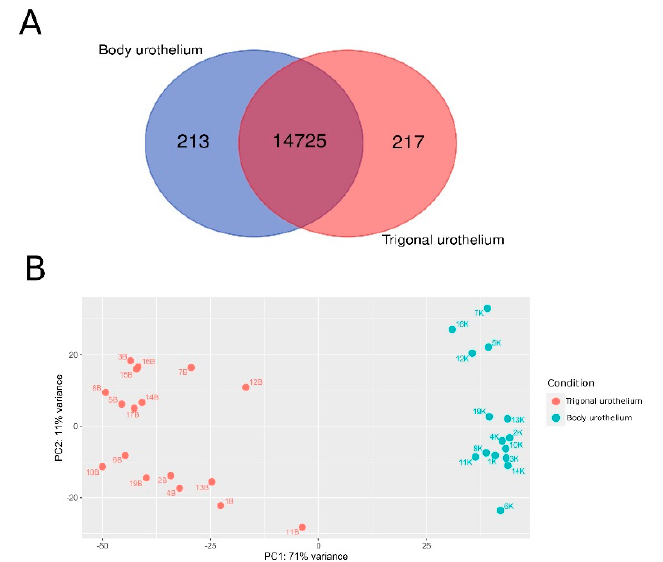
Figure 2. ( A ). Numbers of common and unique genes with noticeable levels of expression (greater than ten reads) in at least three urothelial samples. ( B ). Principal component analysis (PCA) based on transcriptomic profiling, showing clustering of the samples according to the origin of the urothelium, with B and K indicating trigonal and body urothelium samples, respectively.